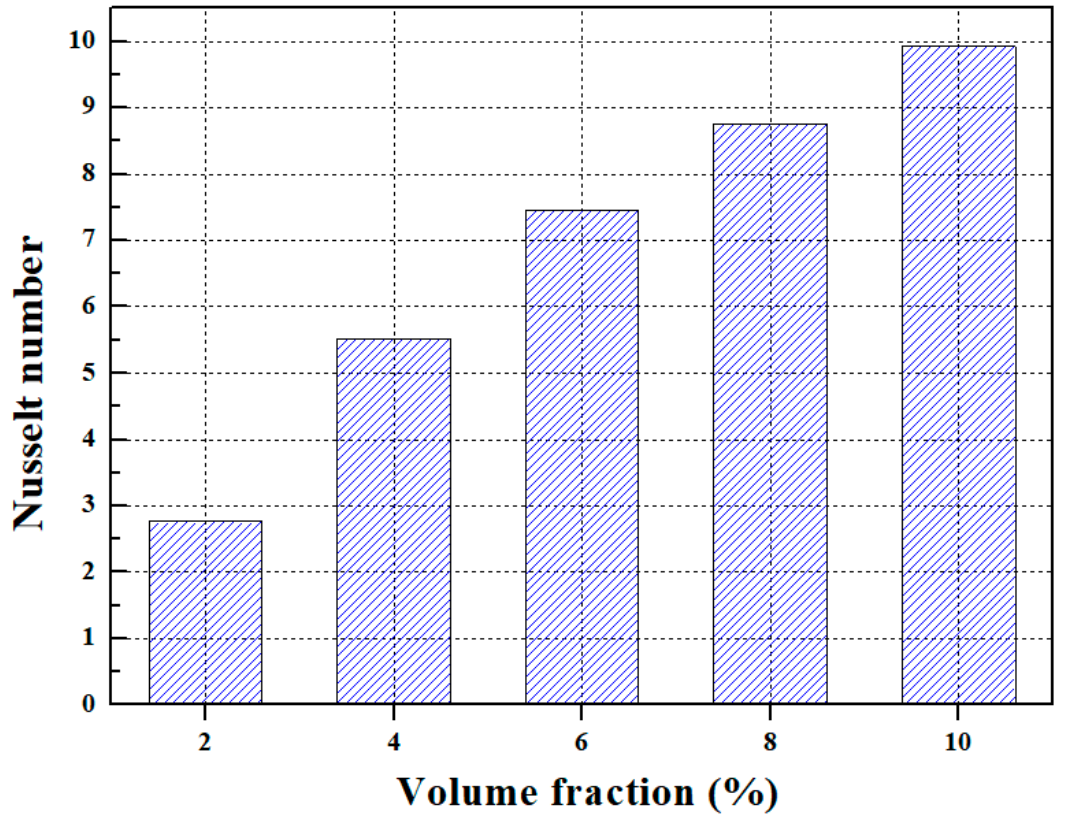
Figure 13. Effect of ferrofluid volume fraction on Nusselt number.